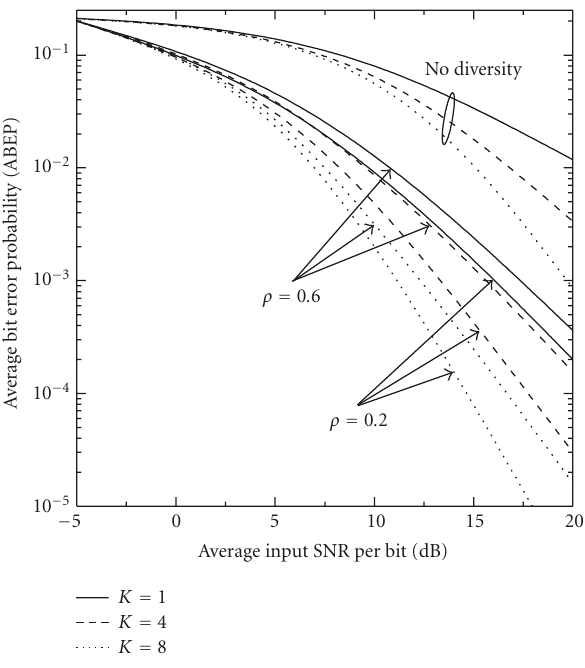
Figure 4: Average bit error probability (ABEP) versus average input SNR per bit for 16-QAM signaling format for di ff erent values of the Ricean K -factor and the correlation coe ffi cient ρ .